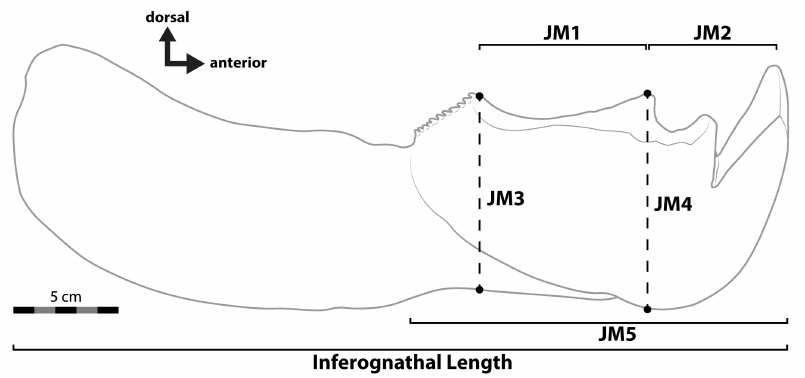
Figure 6. Inferognathal of Dunkleosteus terrelli (CMNH 5698, reversed), showing the measurements